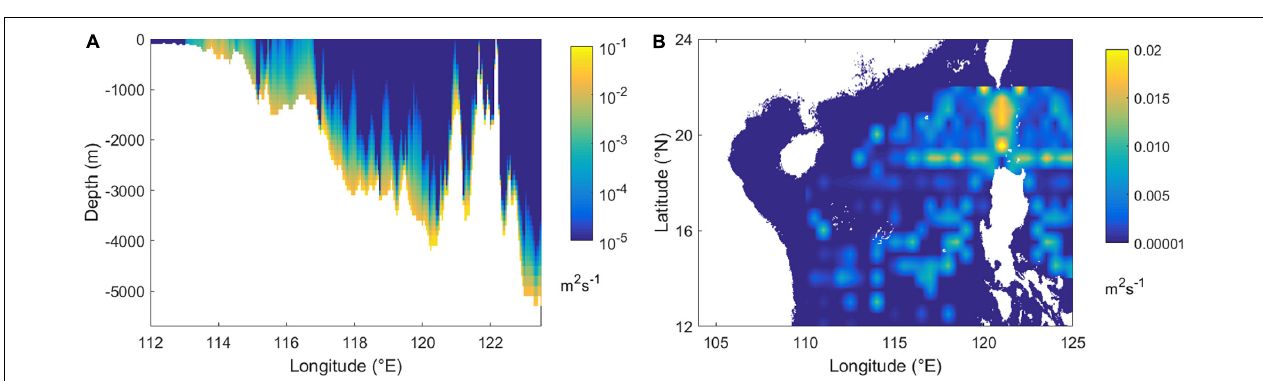
FIGURE 2 | (A) Cross-section distribution of the diapycnal diffusivity along 20 ◦ N in IE1-2 and (B) horizontal distribution of the diapycnal diffusivity.